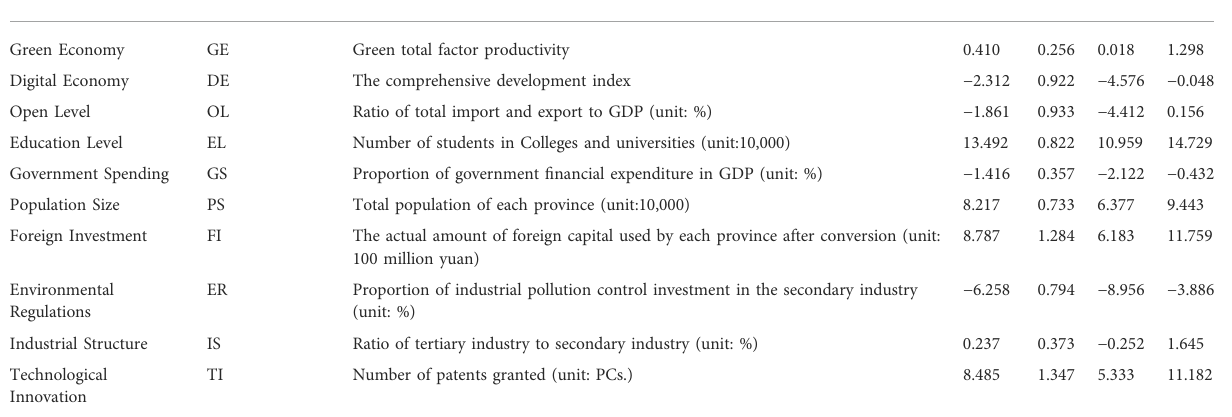
TABLE 3 Statistical